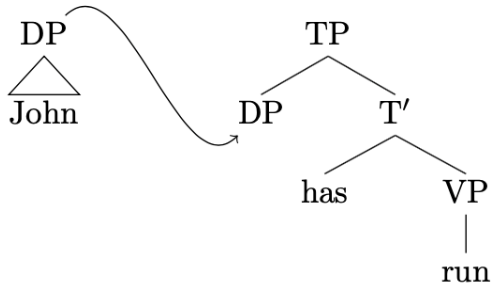
Figure 7. Elementary trees following [19,21]. In this case, only lexical categories head independent elementary trees: the DP is the extended projection of the lexical category N, and the TP is the extended projection of the lexical V (see also [24,25]).